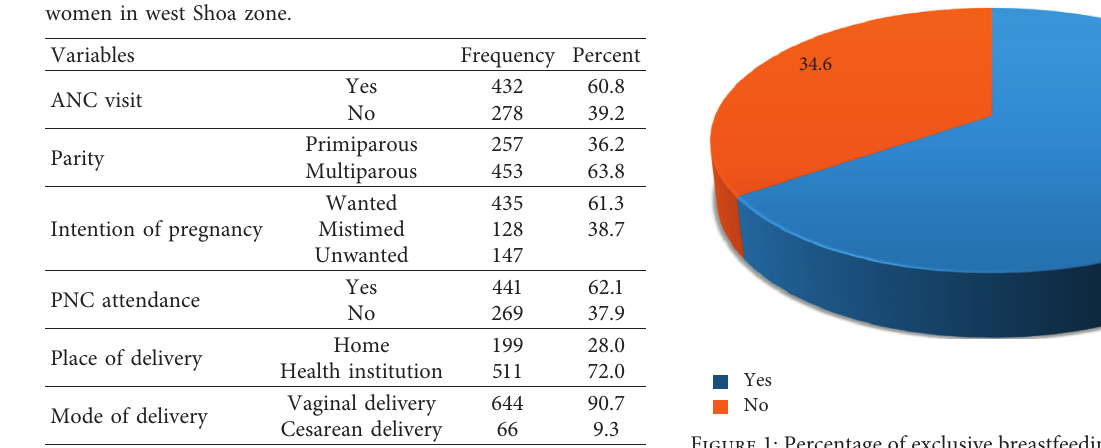
Figure 1: Percentage of exclusive breastfeeding among mothers in west Shoa